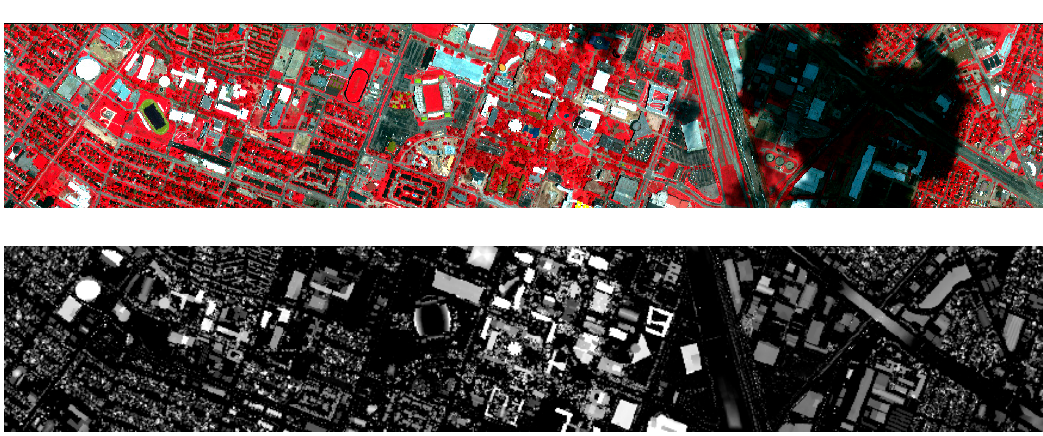
Figure 1. False color composite of hyperspectral imagery (top) and the normalized digital surface model (nDSM) derived from LiDAR data (bottom).